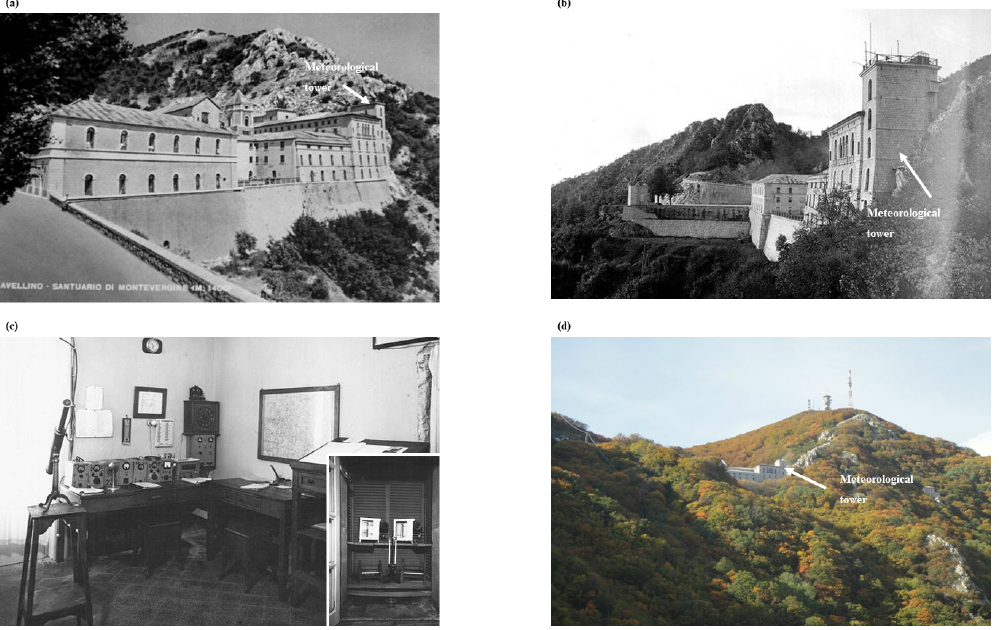
Figure A1. Panels (a) and (b) : historical view of the MVOBS meteorological tower from a south-eastern and a northern direction, re- spectively. Panel (c) : the observatory room in 1950. The small picture in the bottom right corner of the panel shows the inside of a Stevenson screen, where thermometric and hygrometric measurements were performed. Panel (d) : a recent panoramic view of the Montevergine abbey and MVOBS. Historical and recent images show that MVOBS is surrounded by a natural high-altitude environ- ment, whose features have remained unchanged over time. Photos in panels (a) , (b) and (c) are courtesy of the Italian Air